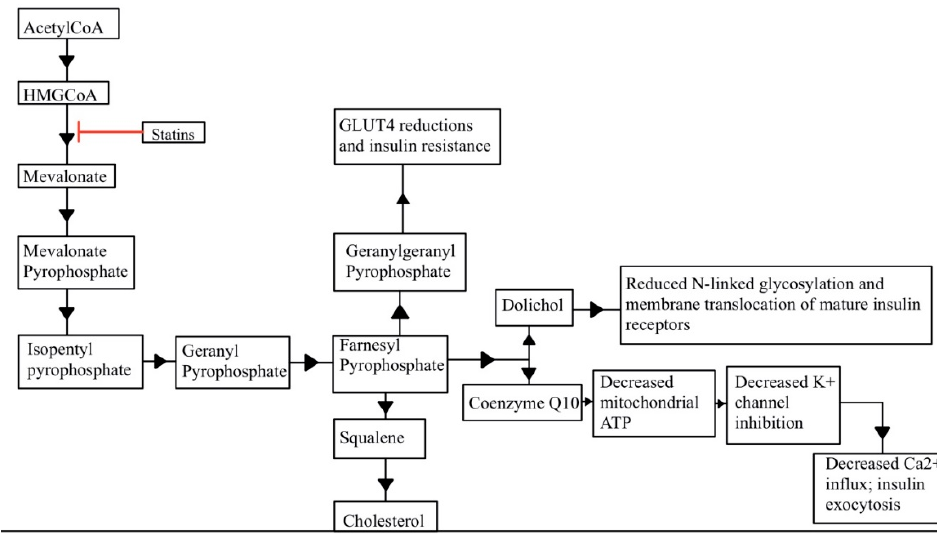
Figure 3. Proposed pathways for statin-induced type 2 diabetes mellitus via inhibition of the cholesterol synthesis pathway. Reductions in GLUT 4 receptors results in decreased insulin sensitivity ( center of figure). Reduced translocation of insulin receptors results in decreased insulin sensitivity ( center right of figure). Reduced calcium influx results in decreased insulin secretion ( bottom right ). ATP, adenosine triphosphate; GLUT 4, glucose transporter type 4; HMG-CoA, β -hydroxy β -methylglutaryl-CoA.